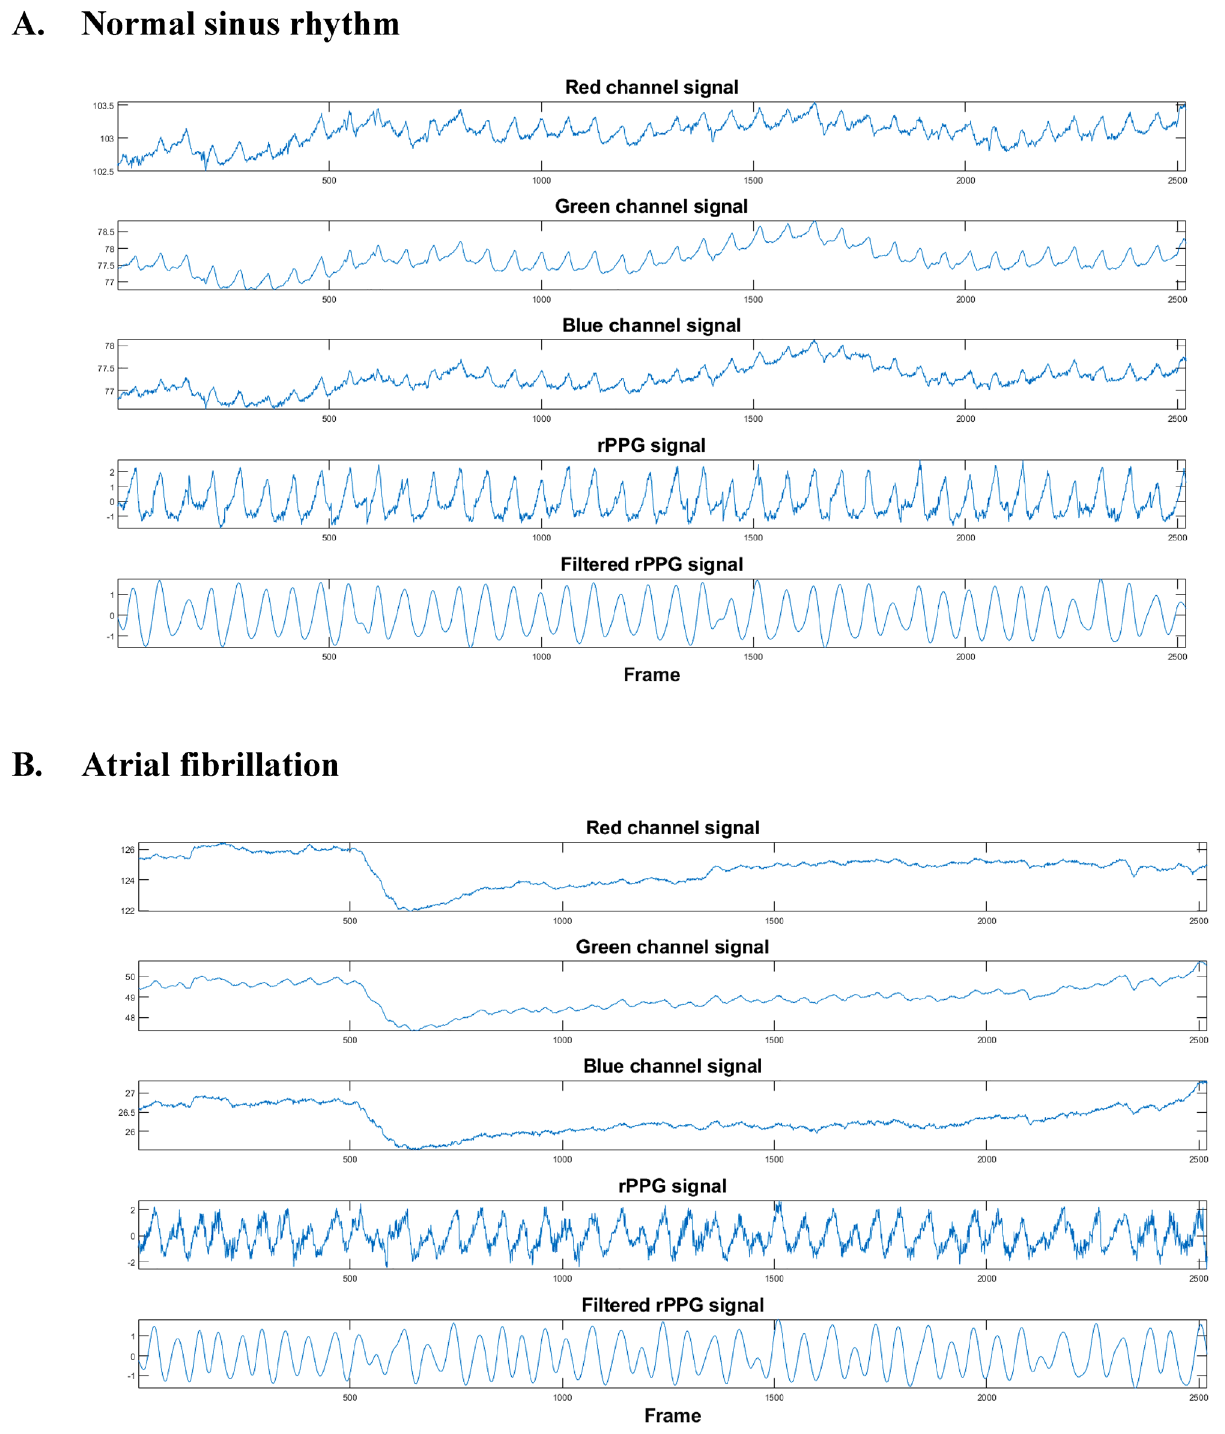
Figure 1. The examples of extracted RGB and rPPG signals. ( A ) Signals of a subject with normal sinus rhythm. ( B ) Signals of a subject with atrial fibrillation. ( C ) Signals of a subject with atrial premature